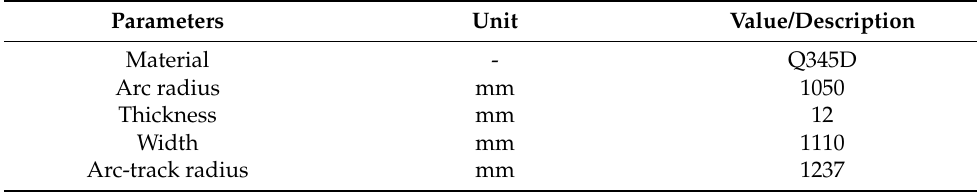
Table 3. Circular arc clamp-type manipulator specification.